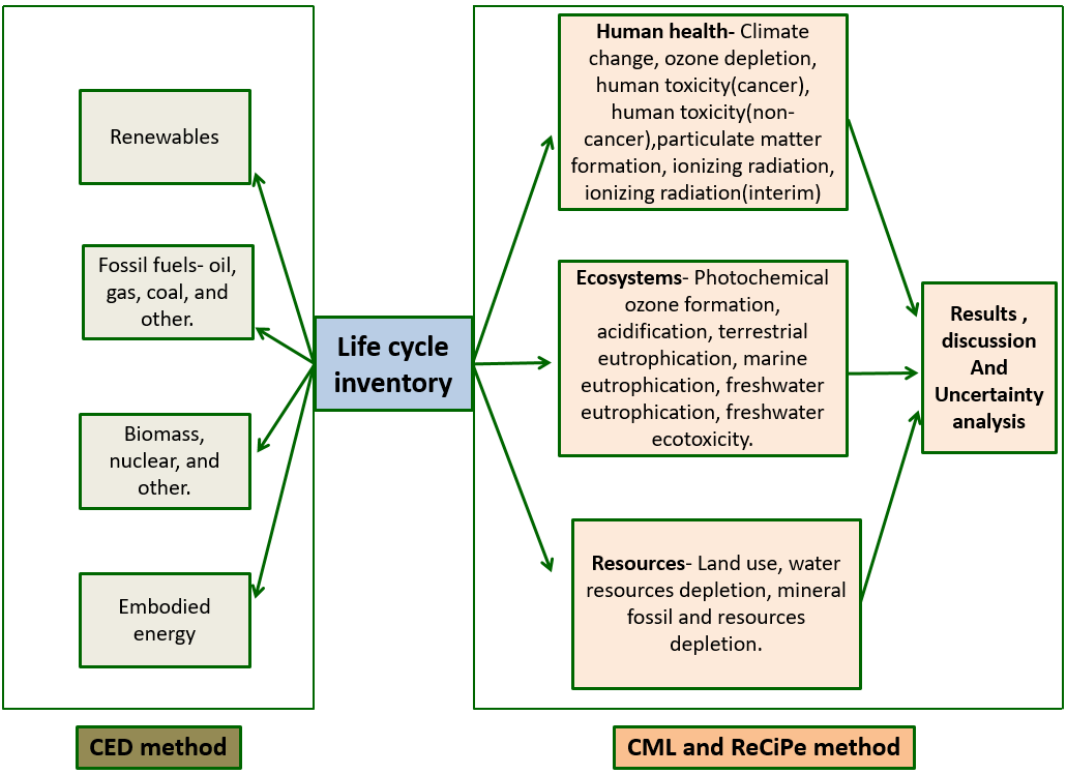
Figure 7. Schematic diagram of the CED and CML methods of LCA